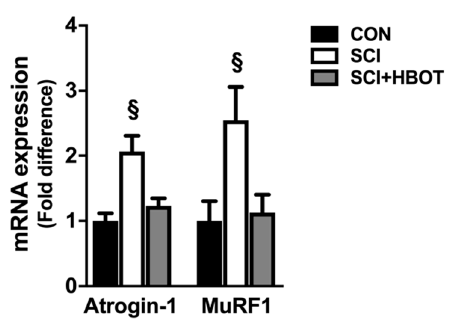
Figure 6. mRNA expression of Atrogin-1/MaFbx and MuRF1. Values are mean ± SEM. § Significantly different versus all groups ( p < 0.05). CON—non-injured, room air exposure; SCI—lateral-cervical spinal cord contusion, room air exposure; and SCI + HBOT—lateral-cervical spinal cord contusion, HBO therapy.